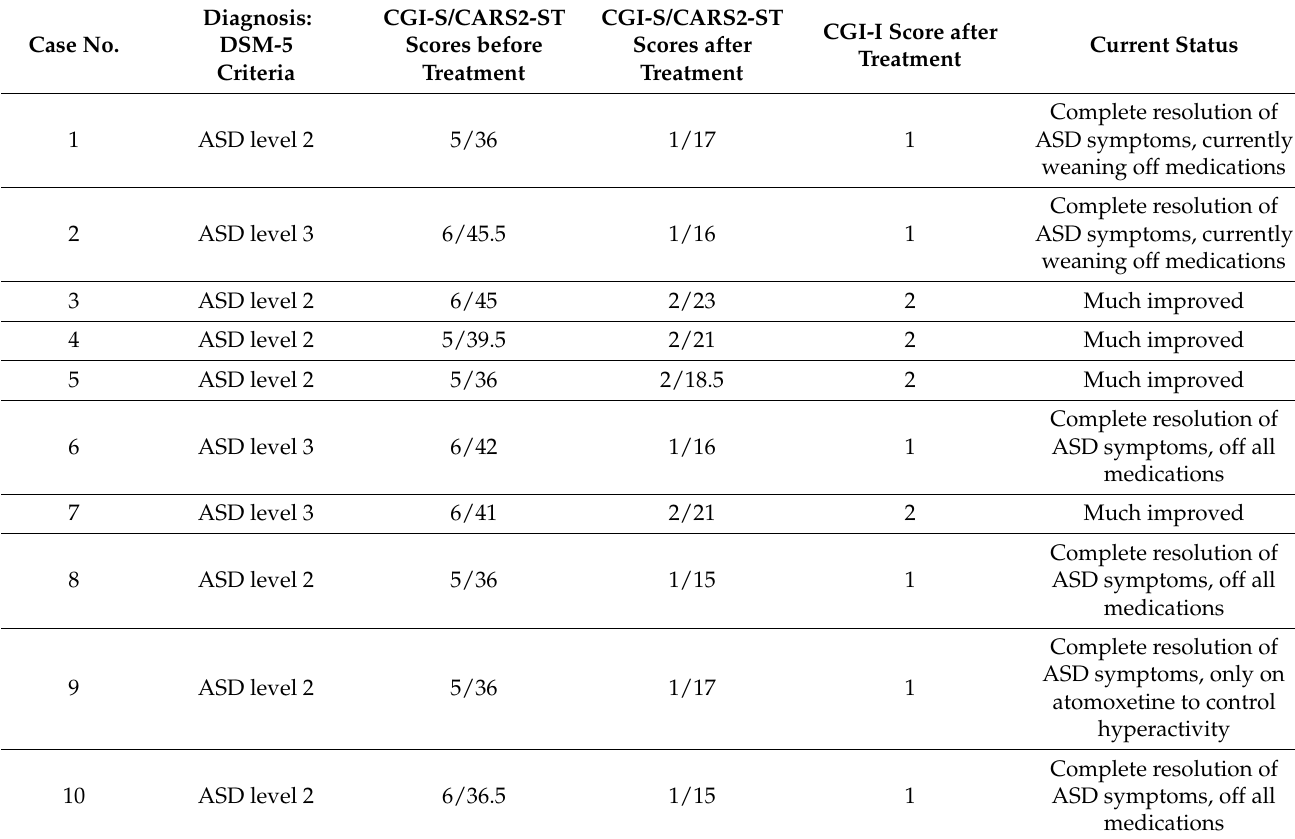
Table 2. Diagnosis, scores at baseline and after treatment, and current status of all 10 patients.